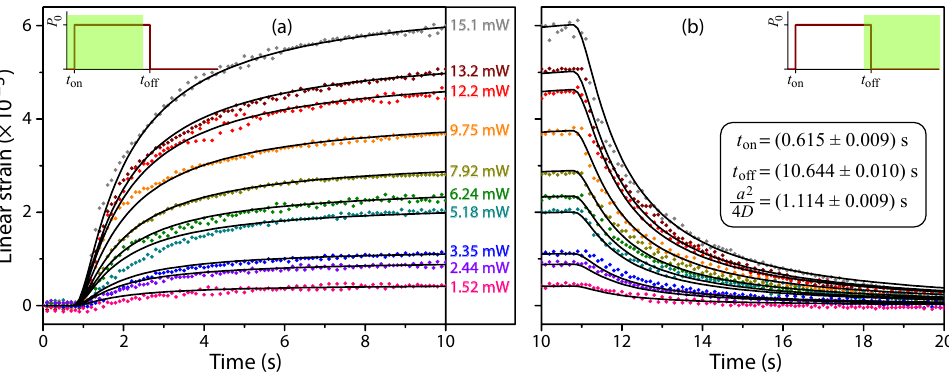
Figure 4. Plots of the strain as a function of time for many values of the pump laser power P 0 . The solid lines are fitted to the entire data set for all pump powers and during both the illumination and dark periods. The fitted lines all share the same values for t on , t off , and a 2 /4 D . The insets illustrate the square pump pulse with the two boxed regions showing the period of data collection when the shutter is ( a ) opened and ( b )